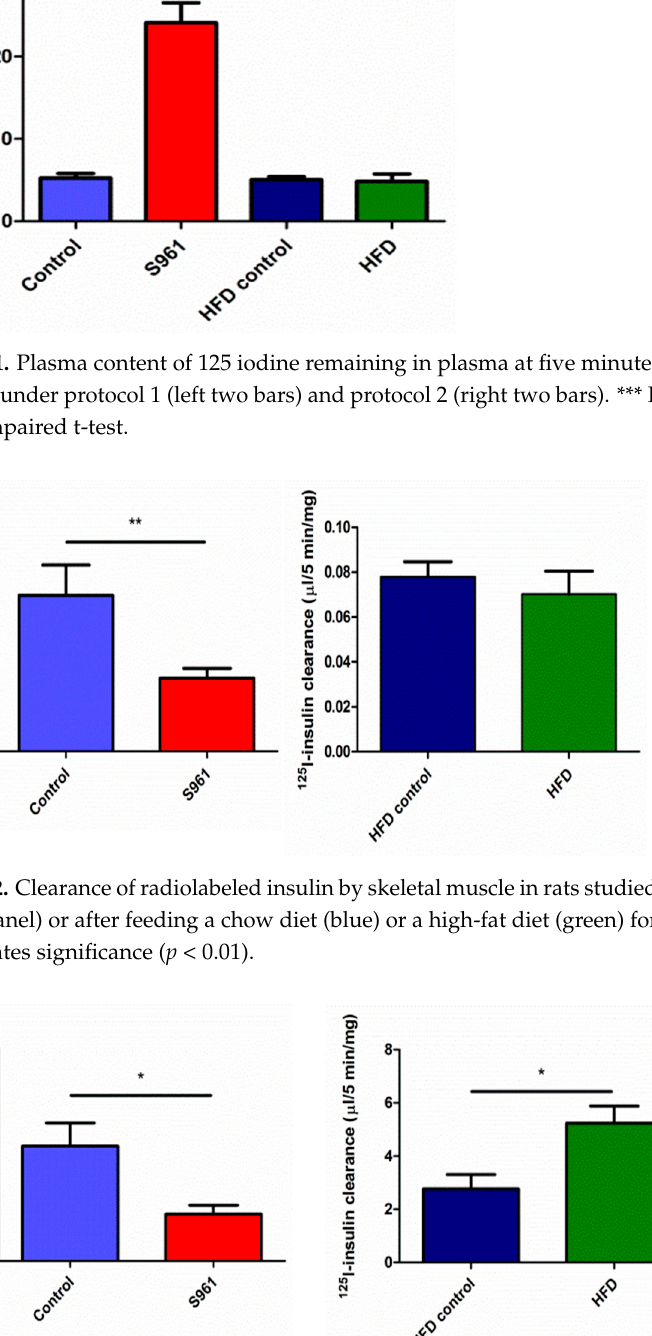
Figure 3. Kidney radiolabeled insulin clearance in rats studied under protocol 1 (left panel) or protocol 2 (right panel). S961 significantly decreased kidney radiolabeled insulin uptake (*; p < 0.002). By contrast, high-fat diet significantly increased insulin clearance ( p <